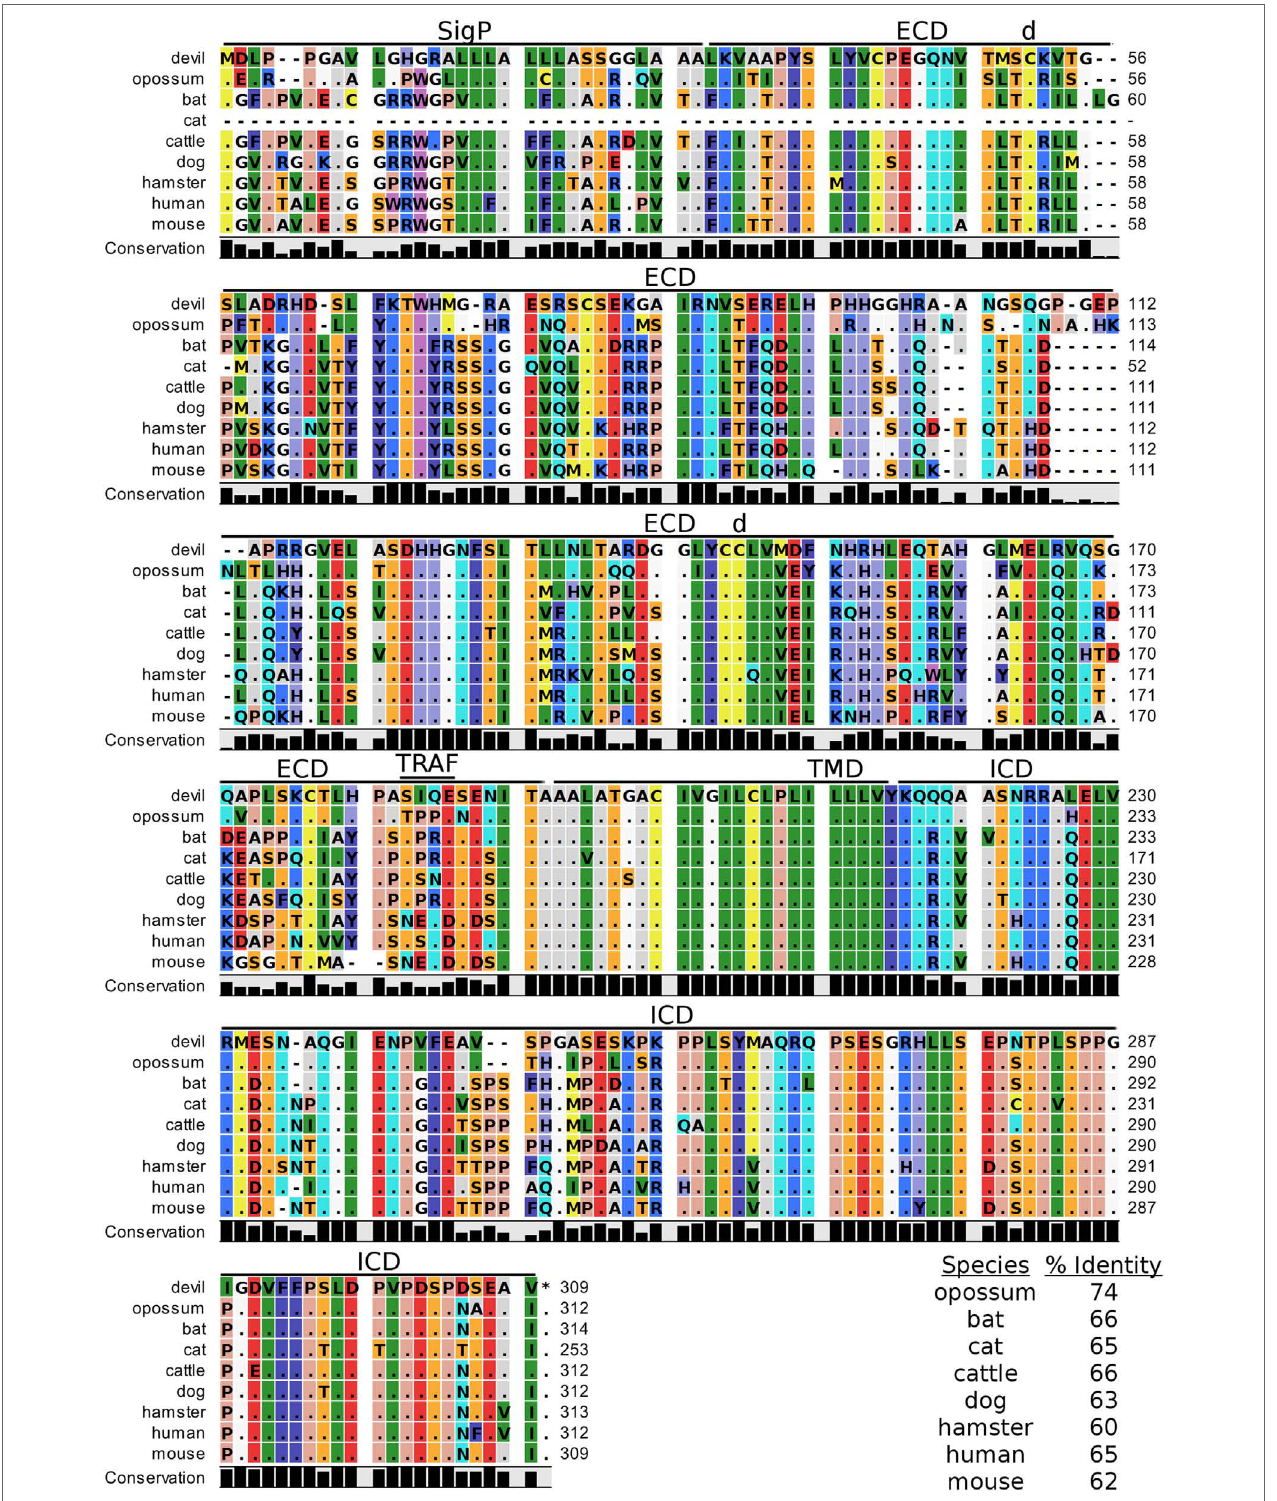
FigUre 6 | alignment of V-domain ig suppressor of T cell activation reference genes for nine species . The predicted signal peptides (SigP), extracellular domain (ECD), transmembrane domain (TMD), and intracellular domain (ICD) are demarcated with bars. “d” above the alignment represents predicted disulfide bonds and “TRAF” indicates a potential TRAF1/2-binding site. The black bar graphs below the alignment represent the conservation of amino acids across all nine species. The percent amino acid sequence identity between devils and other species is shown in the bottom right corner of the alignment.